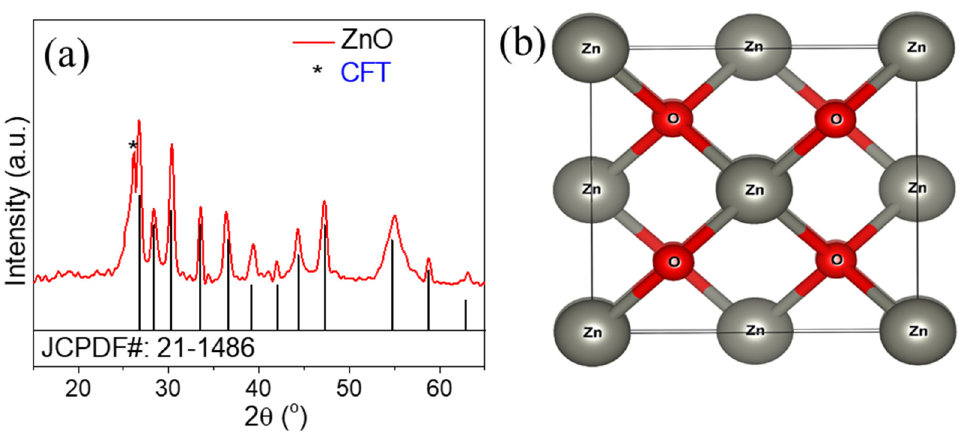
Figure 3. ( a ) XRD pattern of ZnO@CFT electrode and ( b ) crystal structure of